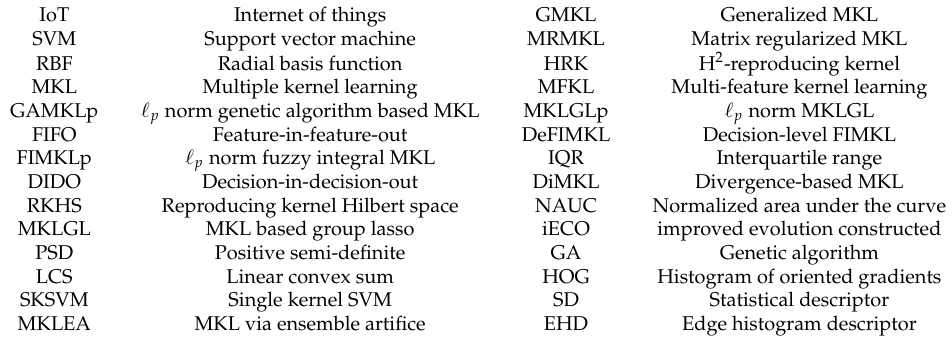
Table 1. Acronyms and